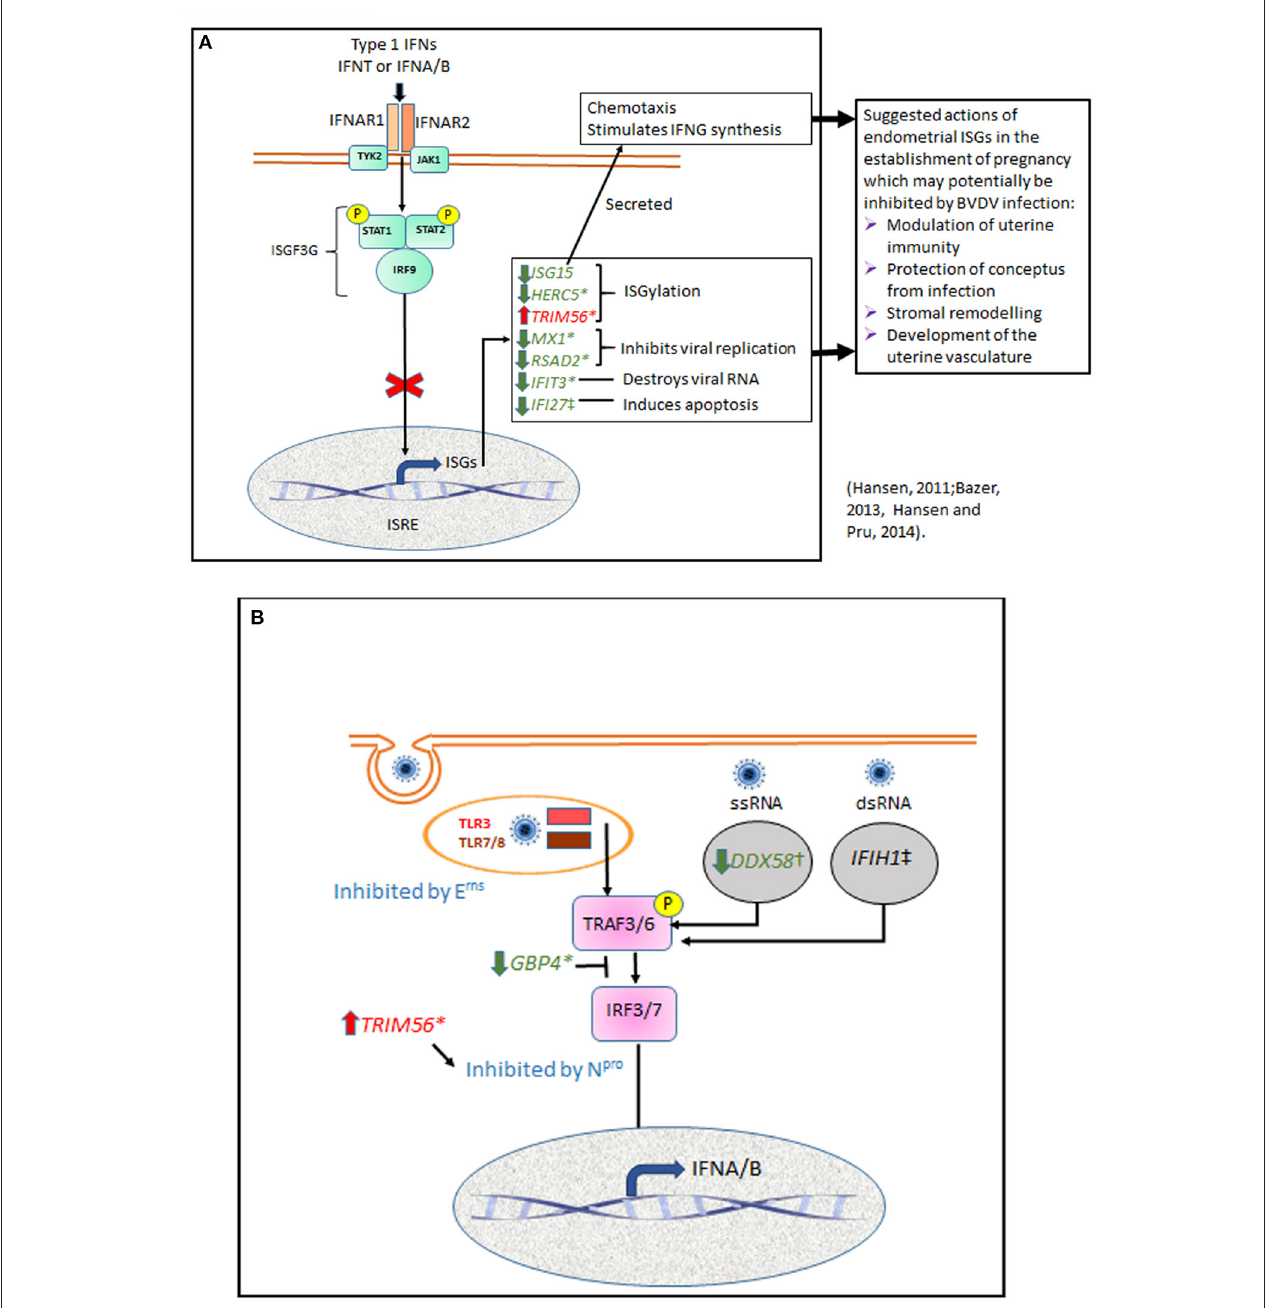
FIGURE 4 | Summary diagram showing potential points in endometrial cell signaling pathways which may be influenced by BVDV infection. (A) Many cell types respond to viral infection by production of type 1 interferons. IFNA and IFNB have similar structure and biological actions to the bovine pregnancy recognition factor IFNT. All three type 1 IFNs bind to interferon alpha and beta receptor subunits 1 and 2 (IFNAR1 and IFNAR2) to initiate cell signaling via the Janus activated kinases (JAKs) and tyrosine kinase 2 (TYK2) pathways. This phosphorylates STAT1 and STAT2, which then dimerise and combine with interferon regulatory factor 9 (IRF9) to form interferon stimulatory gene factor 3 gamma (ISGF3G) which translocates to the nucleus and activates interferon stimulated response elements (ISRE) to induce transcription of ISGs. We showed previously that ncpBVDV-1 infection of endometrial cells inhibited transcription of IFNAR1 , IFNAR2, TYK2, STAT1, STAT2 , and IRF9 (25). Inhibition of this pathway will reduce transcription of most ISGs, as confirmed in the present study. ISGs shown in green were inhibited by ncpBVD-1 whereas TRIM56 , shown in red, was stimulated. Possible effects of these changes in gene transcription on processes important for placental establishment are suggested (27, 29). (B) In order to infect cells, BVDV is taken up by endocytosis and incorporated into the endosome, where it may be sensed by TLR3 or TLR7/8. For replication to occur, viral RNA is released into the cytoplasm where it can be detected by the pattern recognition receptors DDX58, which recognizes ssRNA, and IFIH1,